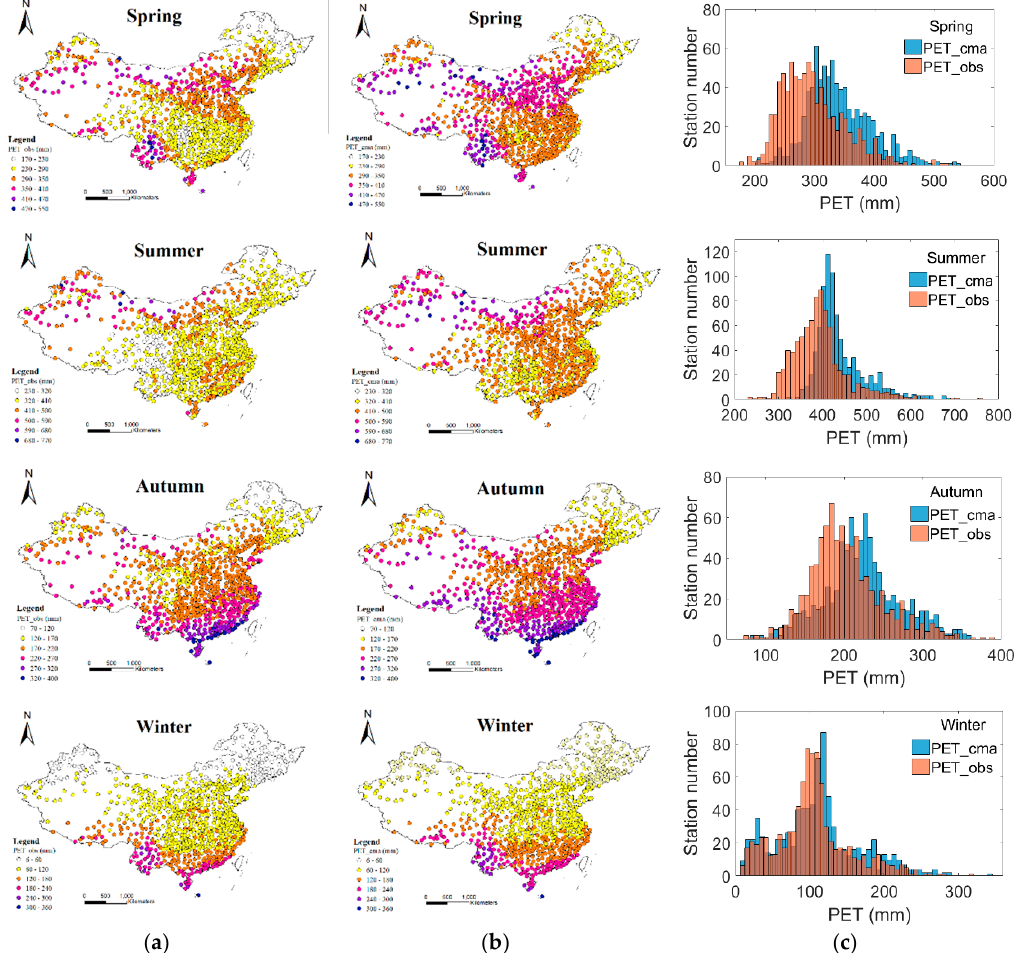
Figure 3. Mean seasonal potential evapotranspiration estimated from weather station data (PET_obs, ( a )), CMADS datasets (PET_cma, ( b )) with their histograms ( c ).